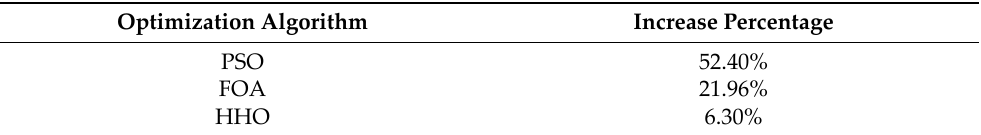
Table 8. IHHO compared with the other three algorithms’ computational efficiency increase